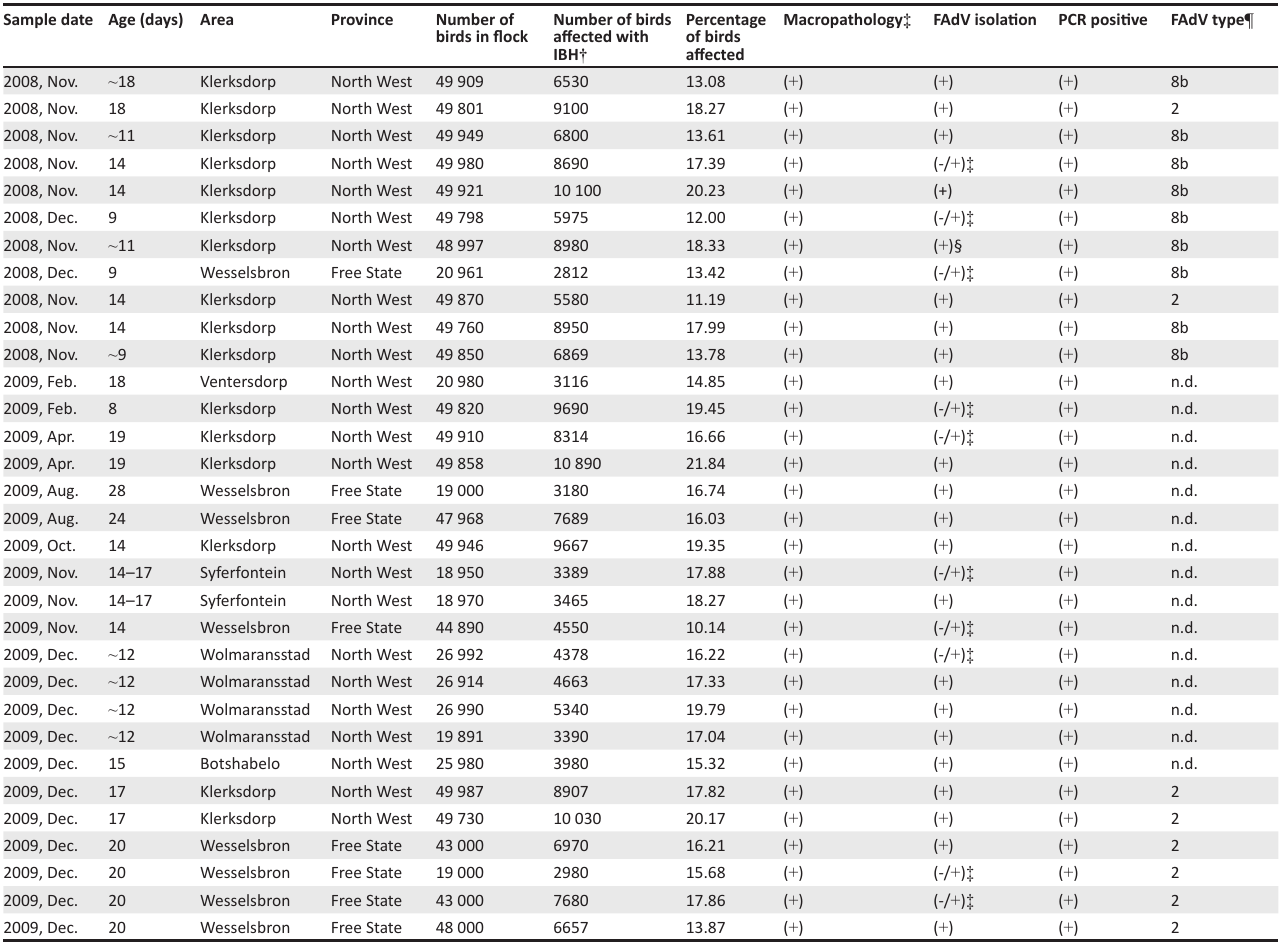
TABLE 1: Summary of the cases of inclusion body hepatitis during 2008 and 2009. Sample date Age (days)